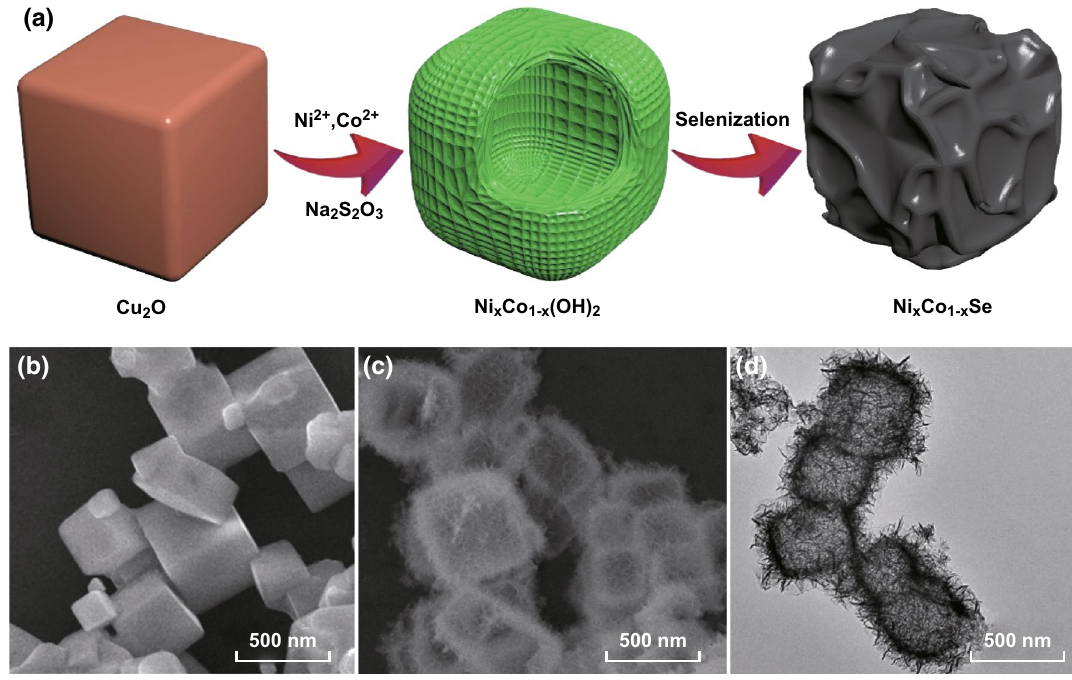
Fig. 1 a Schematics of the fabrication process for the Ni x Co 1− x Se nanocages. Representative SEM images of b the Cu 2 O cubes and c the Ni 0.2 Co 0.8 (OH) 2 nanocages. d Representative TEM image of the Ni 0.2 Co 0.8 Se